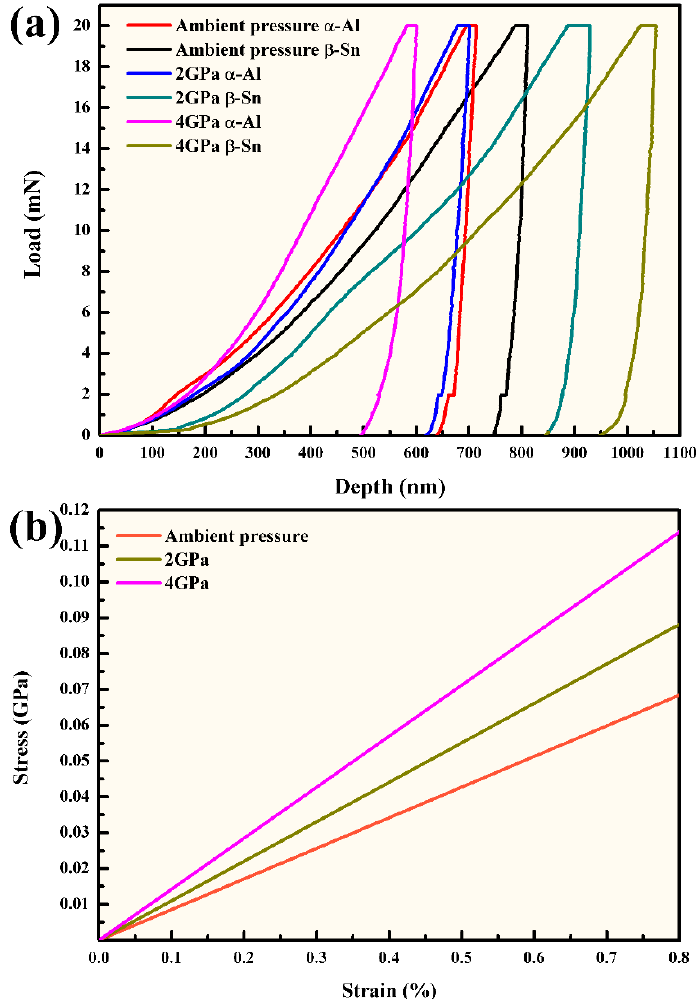
Figure 6. The nano-hardness measurement of α -Al phase and β -Sn phase. ( a ) The load–depth curve of α -Al phase and β -Sn phase, ( b ) the stress-strain curves of α -Al phase.